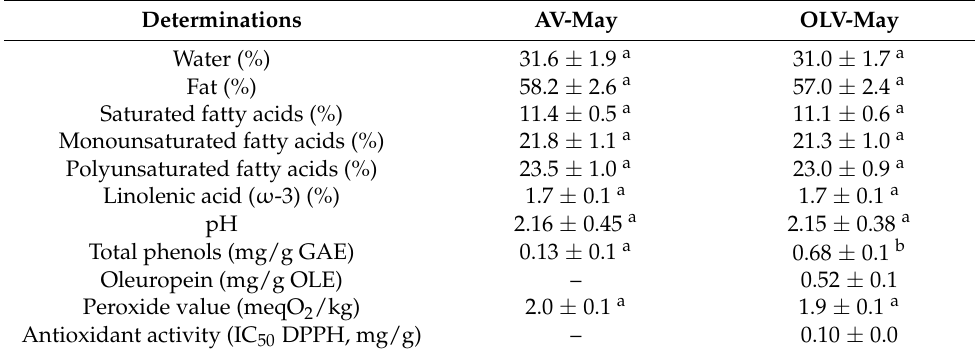
Table 2. Analytical determinations of the mayonnaise samples (AV-May: 18% alcohol vinegar mayonnaise sample; OLV-May: olive leaf vinegar mayonnaise sample)